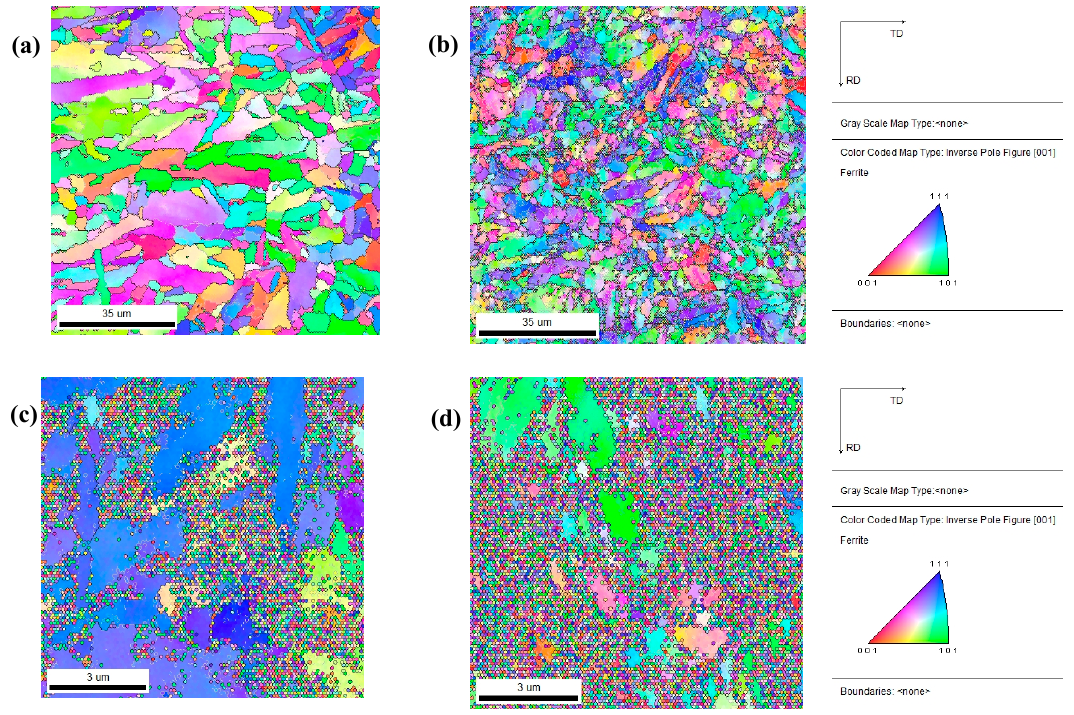
Figure 3. EBSD (electron backscattered diffraction) images along with mapping of the bulk ( a , b ) and 3D-printed ( c , d ) AISI H13 tool steel specimens before and after UNSM treatment.